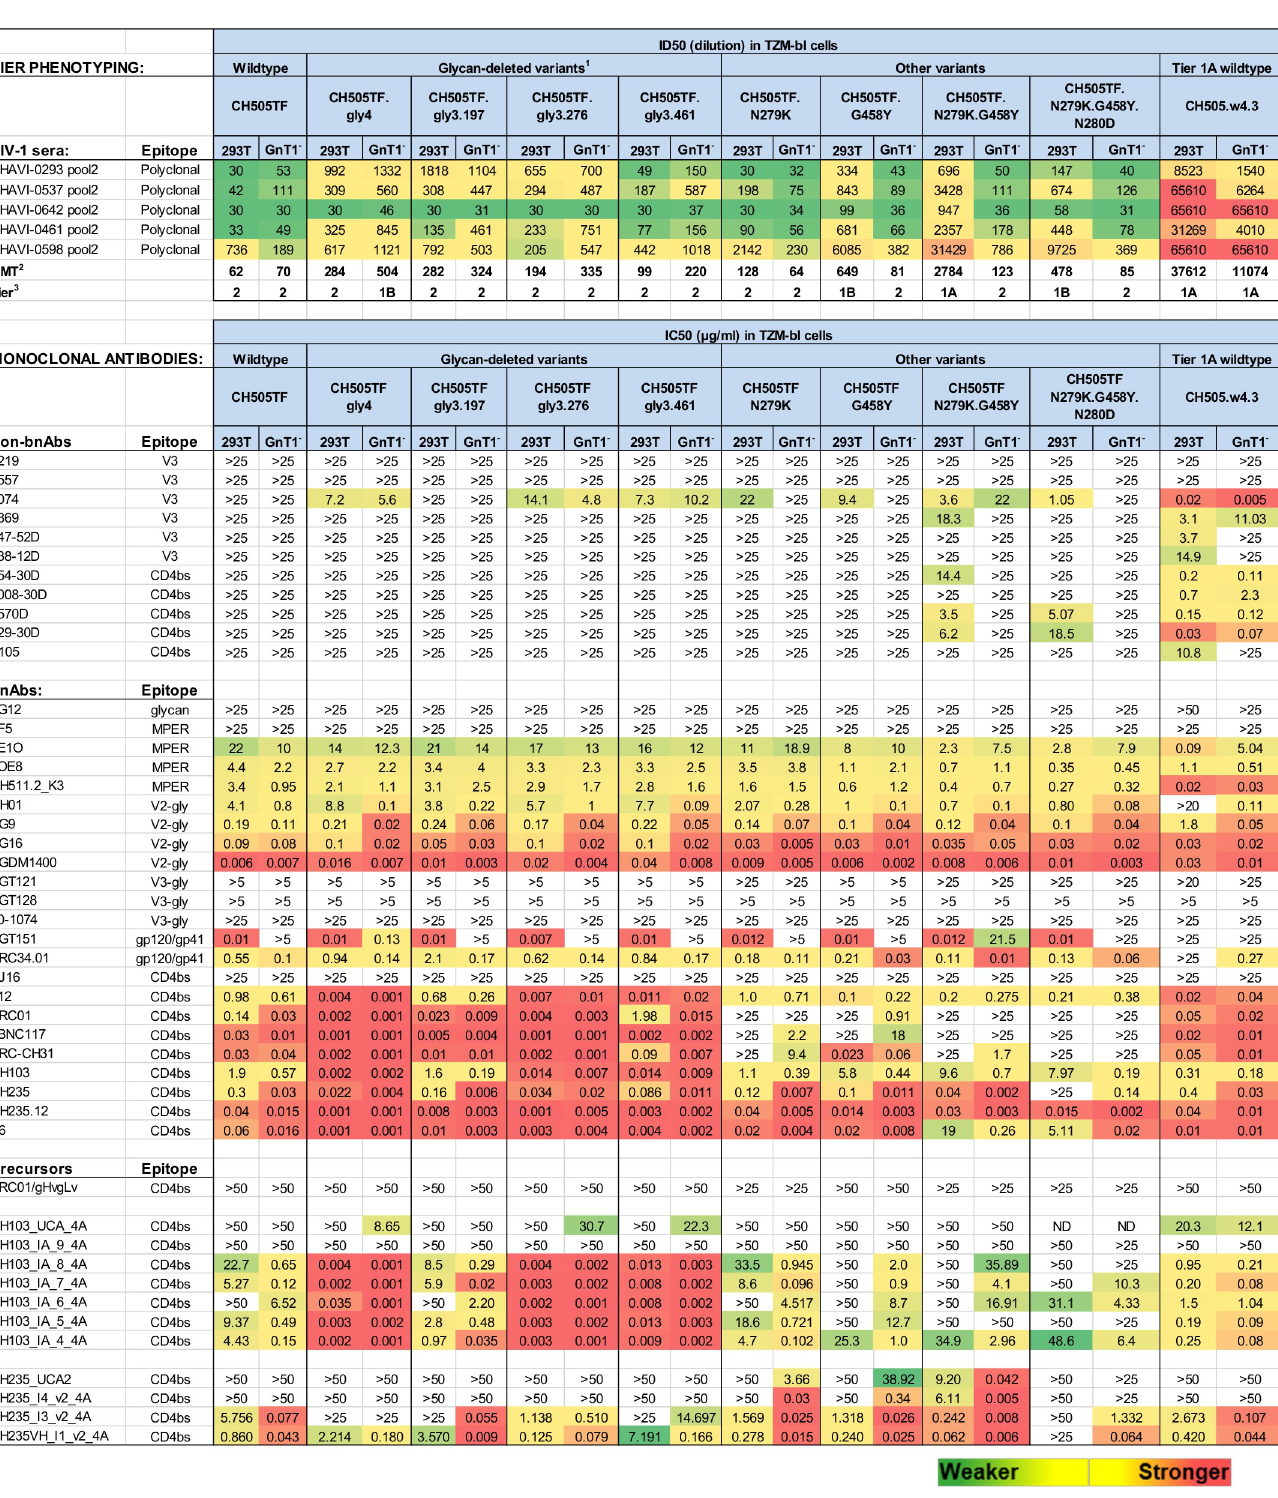
Fig 1. Neutralization phenotype of parental and mutants of CH505TF produced in 293T and 293S GnT1 - cells. Neutralization tier phenotypes were characterized with pooled serum samples from 5 HIV-1 infected individuals (CHAVI samples). Additional neutralization phenotyping was performed with monoclonal antibodies. 1 CH505TF.gly4 (197, 461/462, 276, 362); CH505TF.gly3.197 (461/462, 276, 362); CH505TF.gly3.276 (197, 461/462, 362); CH505TF.gly3.461 (197, 276, 362). 2 GMT, geometric mean titer. 3 Tier classification: Tier 1A (ID50 > 2000), Tier 1B (ID50 350–2000), Tier 2 (ID50 50–349), Tier 3 (ID50 < 50). ND, not done. Neutralization curves for the UCAs and intermediates of CH103 and CH235 are shown in S1A–S1K Fig.